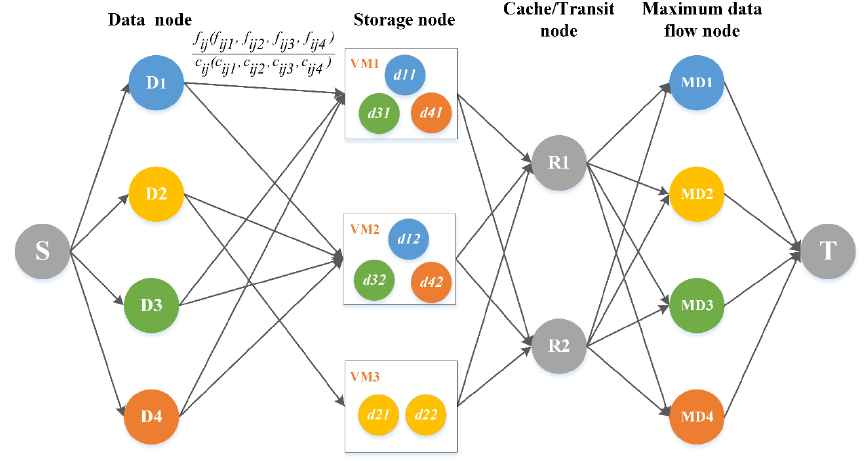
Figure 3. Maximum flow scheduling model.